Question: What kind of plot is shown here?
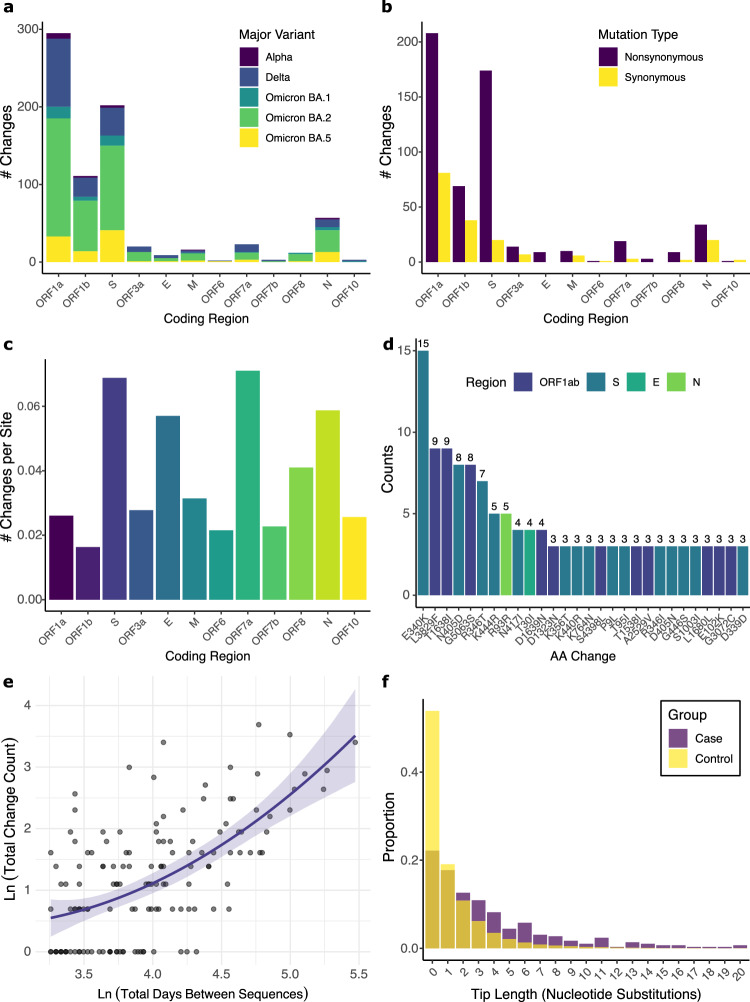
Answer: scatter